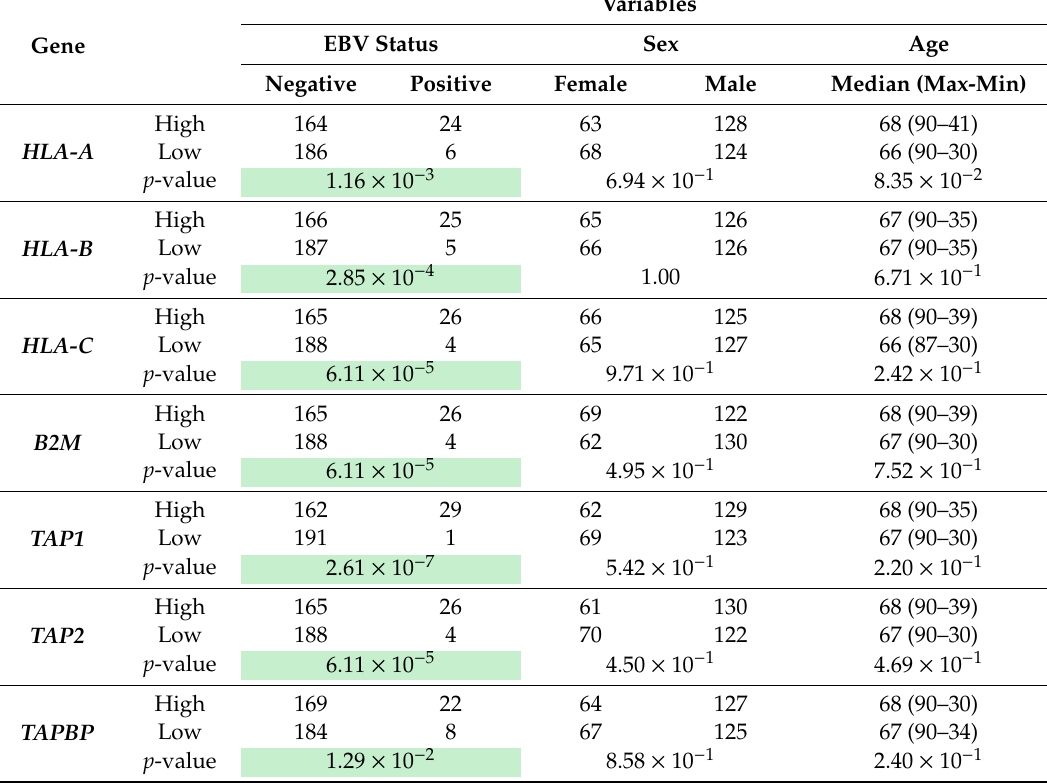
Table 1. Analysis of correlations between mRNA levels of the indicated major histocompatibility complex class I (MHC-I) genes and patient characteristics, including Epstein–Barr virus (EBV) status, sex, and age. Green shading indicates statistical significance ( p <